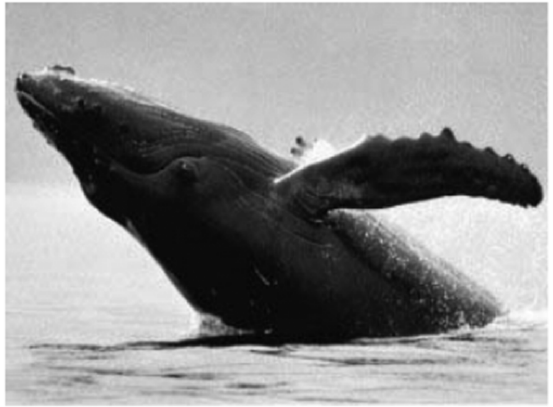
Figure 15. Humpback whale’s